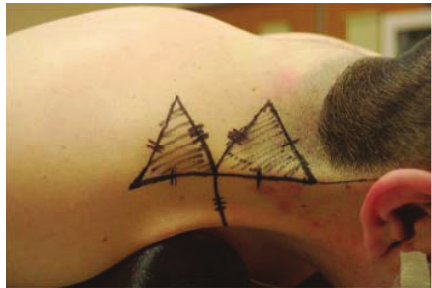
Figure 4: Fibrotic fascial band is excised and trapezial webbing is effectively